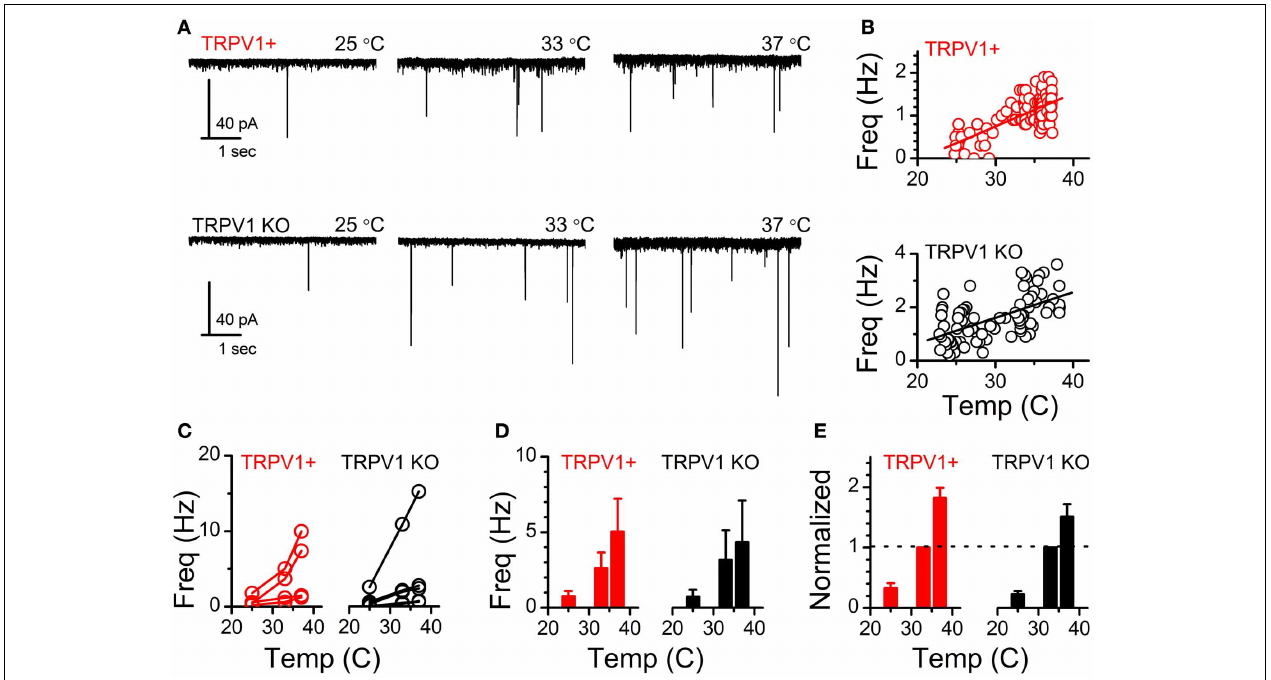
FIGURE 7 | Temperature driven changes in sEPSC frequency across the physiological range are not different from TRPV1 KO afferents. (A) Current traces of temperature driven increase in sEPSC frequency from TRPV1+ and TRPV1 KO mice. (B) Scatter-plot showing binned average frequency (10s bins) across changing temperatures from the TRPV1 + and TRPV1 KO neurons shown in (A) . (C) Frequency of sEPSCs at each